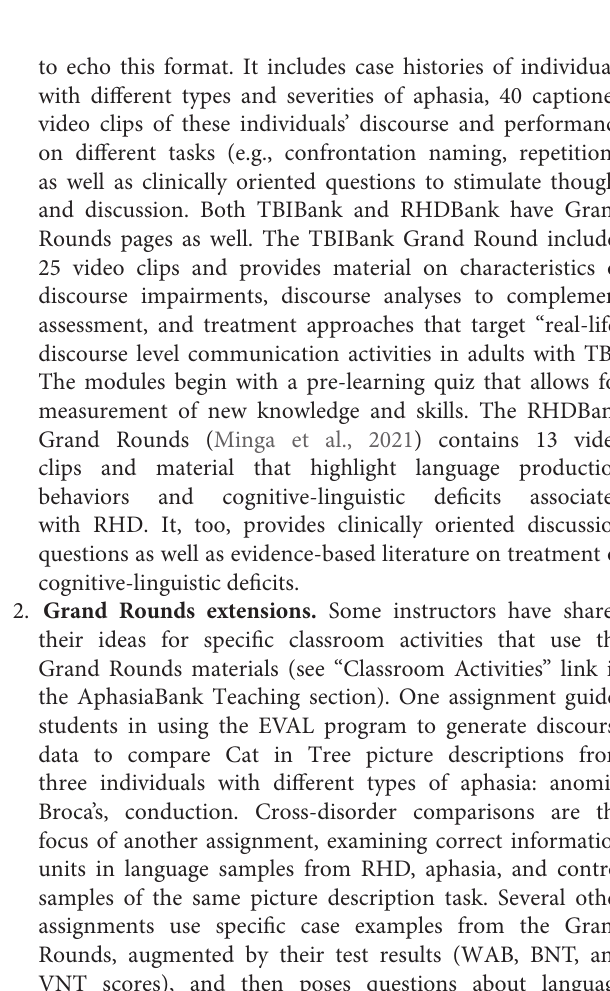
FIGURE 10 | A TalkBankDB CQL